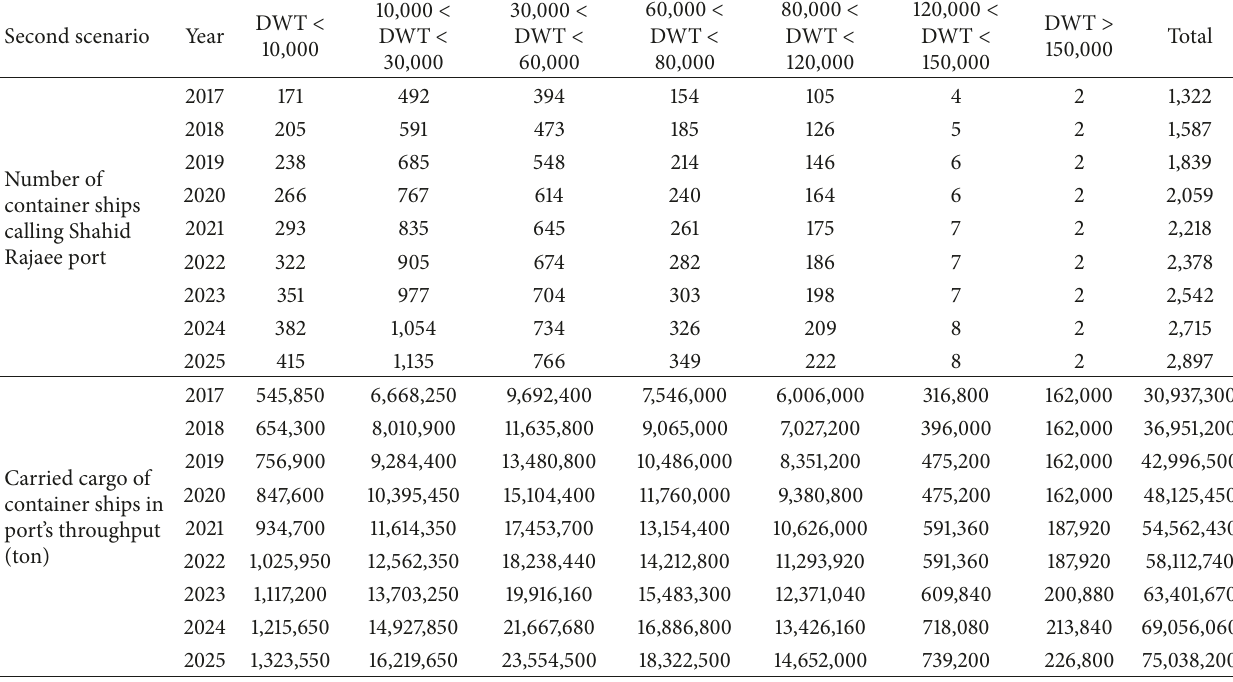
Table 3: Number of container ships and their carried cargo (ton) in port container throughput (predicted from 2017 to 2025) based on the second scenario